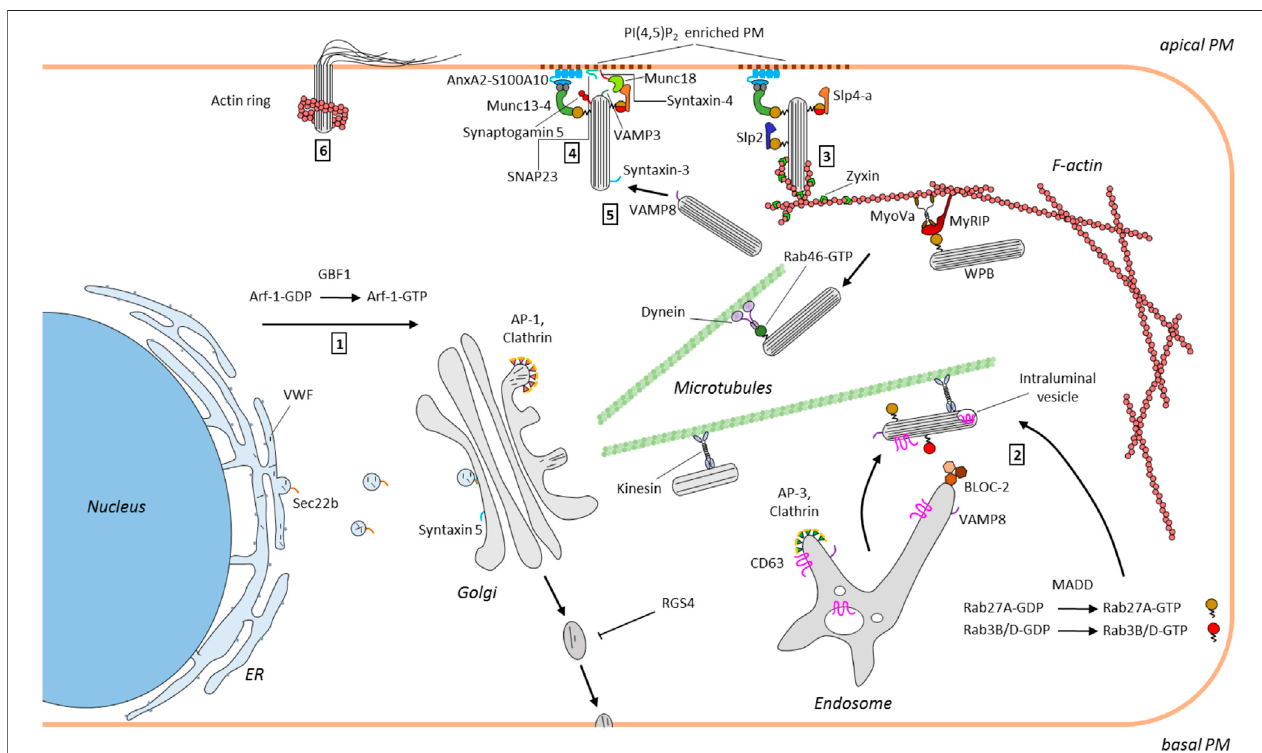
FIGURE1| SchemedepictingtheWPBitineraryinendothelialcells.WPBformationisdrivenbyVWFthatisproducedattheERandtraf fi ckedtotheGolgi(1).WPB thatbudfromtheTGNinanAP-1andclathrindependentprocessarethentransportedtothecellperipheryalongmicrotubules.ThisisaccompaniedbytheBLOC-2and annexin A8 dependent transfer of endosomal components such as CD63 and VAMP8 to WPB (2). Maturing WPB acquire certain RabGTPases, e.g. Rab27A and Rab3B/D, the former required for linking WPB at the cortical actin cytoskeleton (via MyRIP/MyoVc) and supporting exocytosis ( via Slp4-a) (3). Secretagogue induced tethering at and fusion with the PM requires dockingfactors, such asthe annexin A2/S100A10/Munc13-4 complex and a SNARE-based fusion machinery and can also involve compound and cumulative events (3, 4 and 5). Finally, post fusion actin rings have been observed that support the full release of highly multimeric VWF (6). Mainly factors identi fi ed in the recent years have been